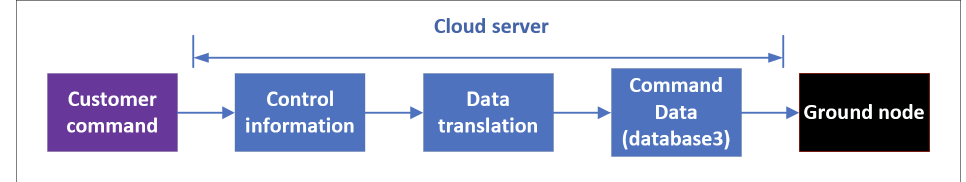
Figure 9. TC data flow.